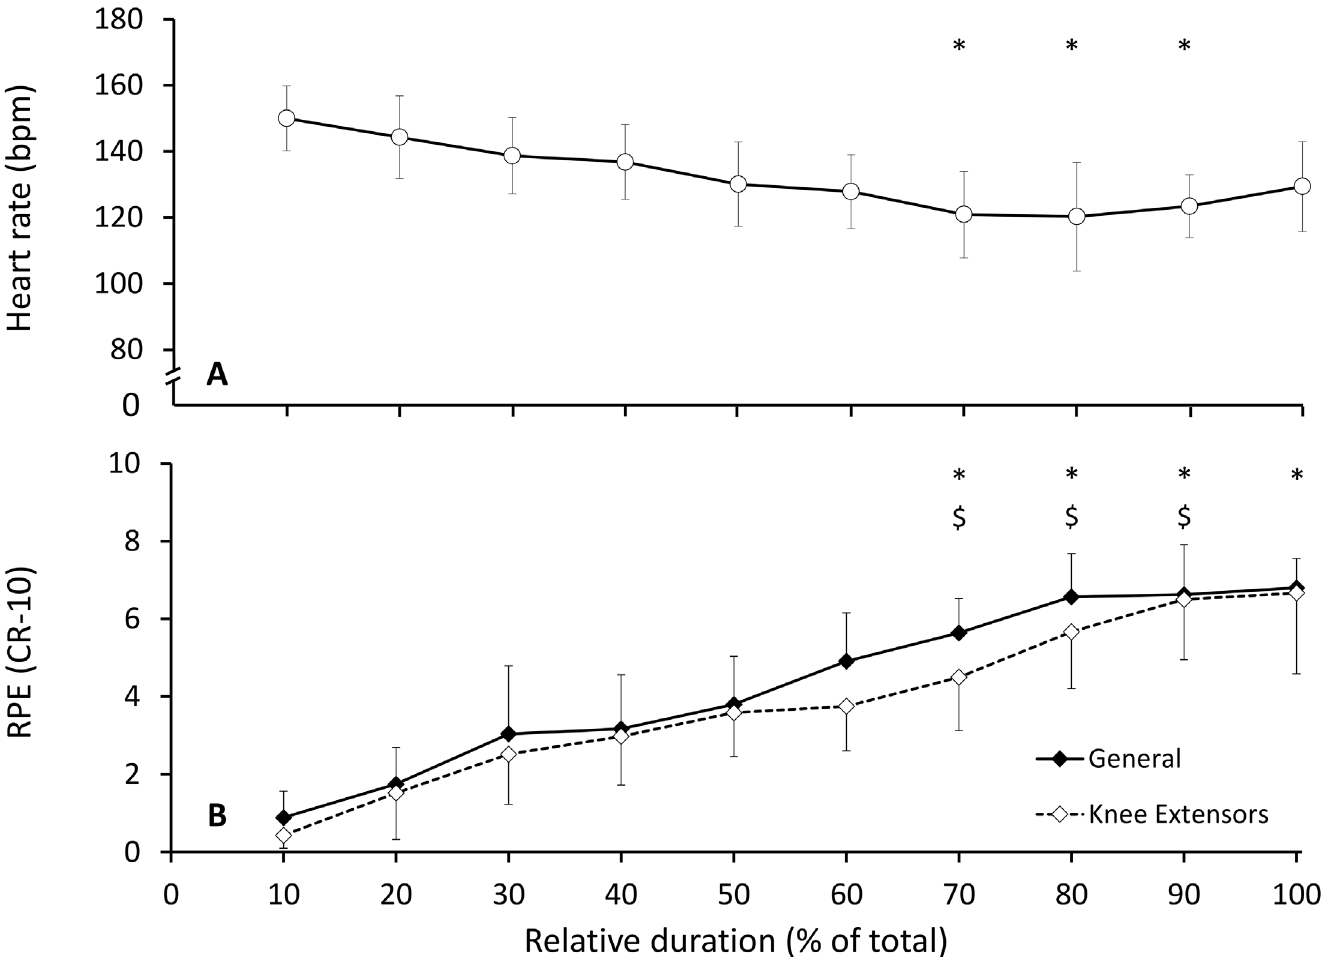
Fig 4. Dynamics of psycho-physiological load. (A) Mean ( ± SD) group heart rate (HR) as a function of total event duration, and (B) general and muscular (knee extensors) ratings of perceived exertion (RPE) as a function of total event duration. Symbols denote significant differences to ( * ) 10% and ($) 20%, at